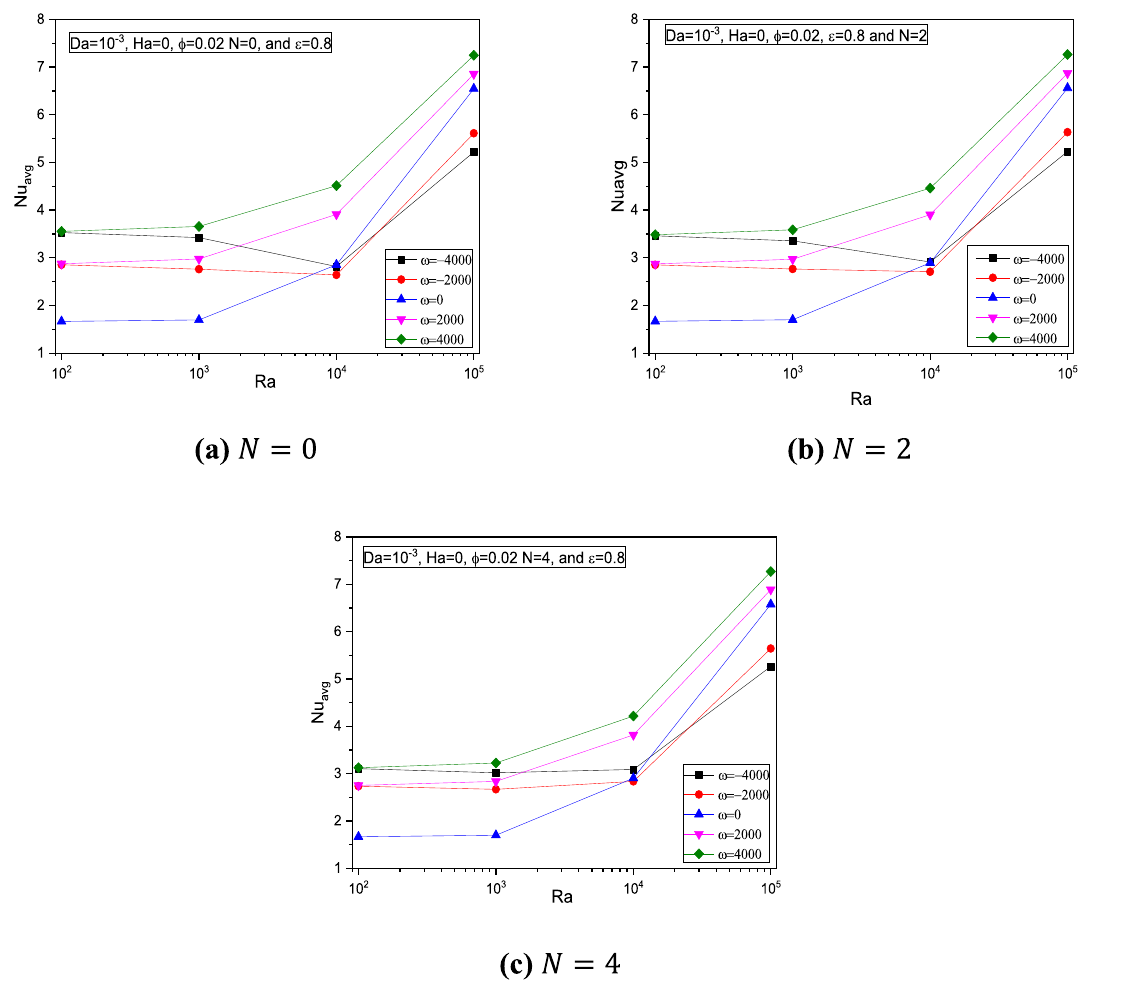
3 10 0 , ε 0.8 , and φ , Ha − = = =